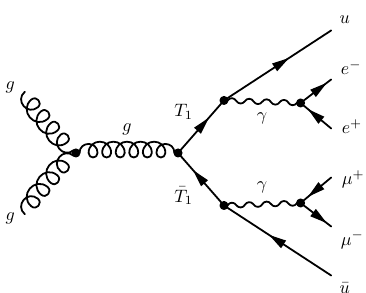
Figure 5. Leading-order Feynman diagram for the VLQ pair-production via gluon-gluon fusion. T represents the lightest up-type VLQ and u/ ¯ u indicate light up-type quarks (up or charm quarks). This diagram provides a larger contribution than that with T 1 uZ 0 vertices. We refer to appendix E for further